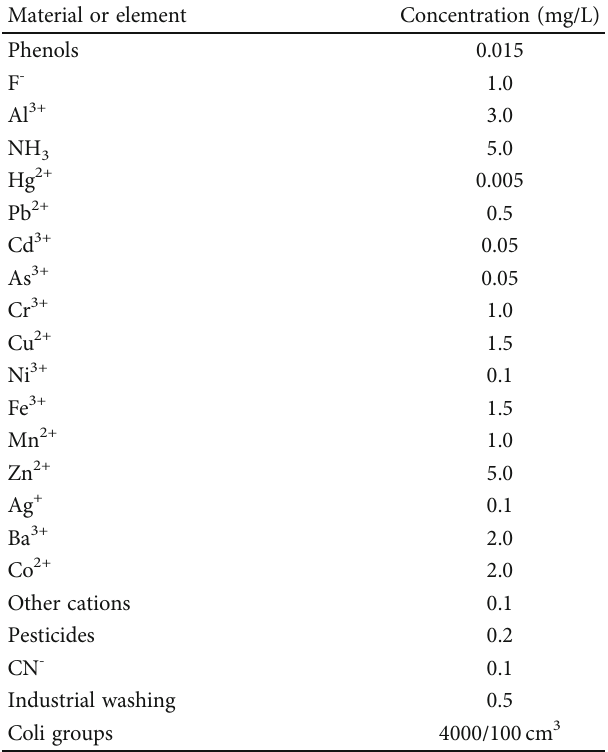
Table 2: The wastewater chemical